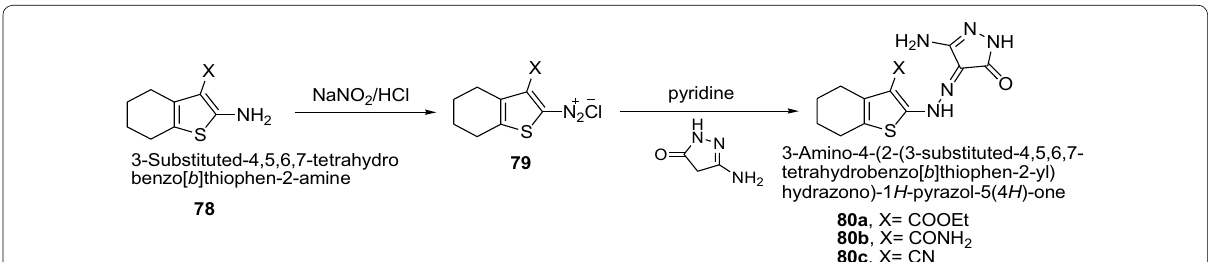
a Drug concentration required to inhibit tumor cell proliferation by 50% after continuous exposure of 48 h; data are expressed as mean experiments performed in duplicates